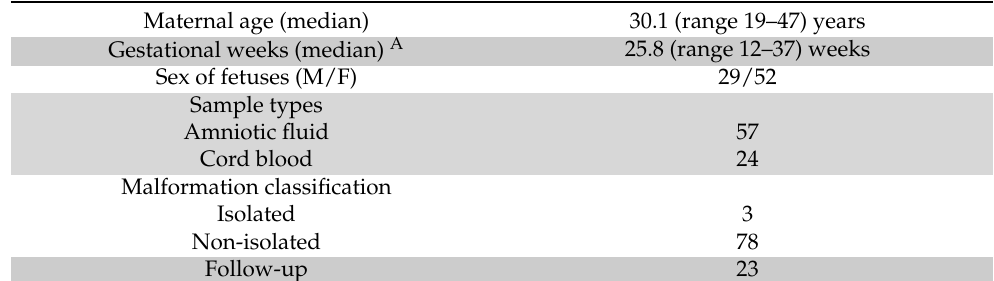
Table 1. Clinical details of 81 fetuses with 16p11.2 microdeletion in the